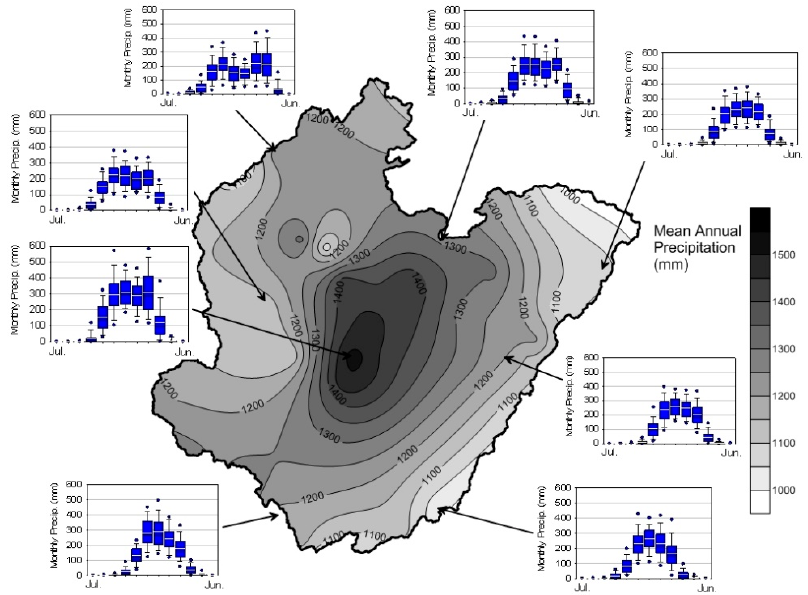
Figure 2. Estimated mean annual precipitation in the Mweru basin, 1925–1986, displaying box and whisker diagrams of monthly historic precipitation at selected sites. The dots represent the fifth and 95th percentiles, the whiskers the 10th and 90th, the boxes the 25th and 75th and the white horizontal bars, the means.